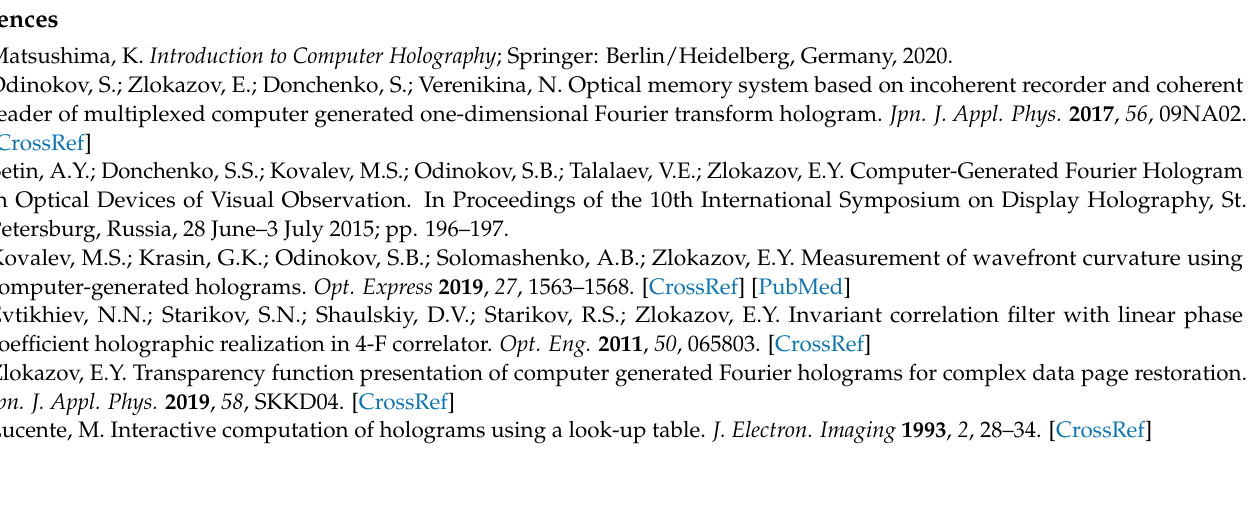
Figure 16. Model of interaction between B2G and G2C with the use of Holomemory.